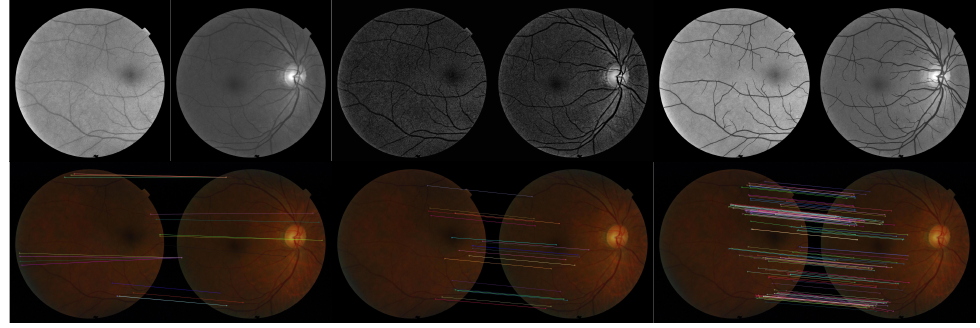
Figure 6. Qualitative comparison of results from different preprocessing methods: min/max normal- ization where pixel values are rescaled, so that the minimum and maximum values of each image are normalized, modified top-hat transform proposed in [28], and the proposed method. The lower row shows the results of applying the SURF method [12] for keypoint matching on the corresponding input frame pairs